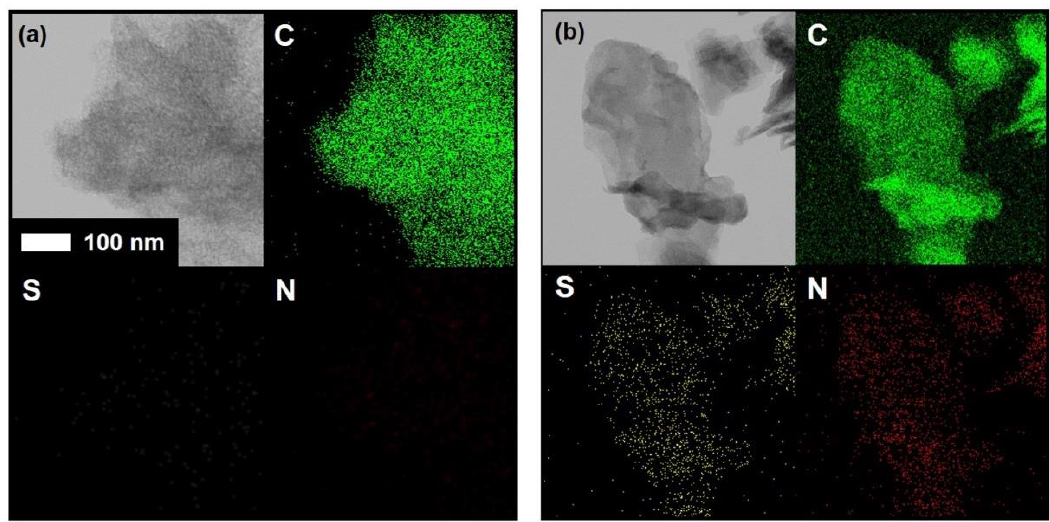
Figure 3. Scanning transmission electron micrographs and elements mapping images of the ( a ) CaC and ( b ) CaC/TU